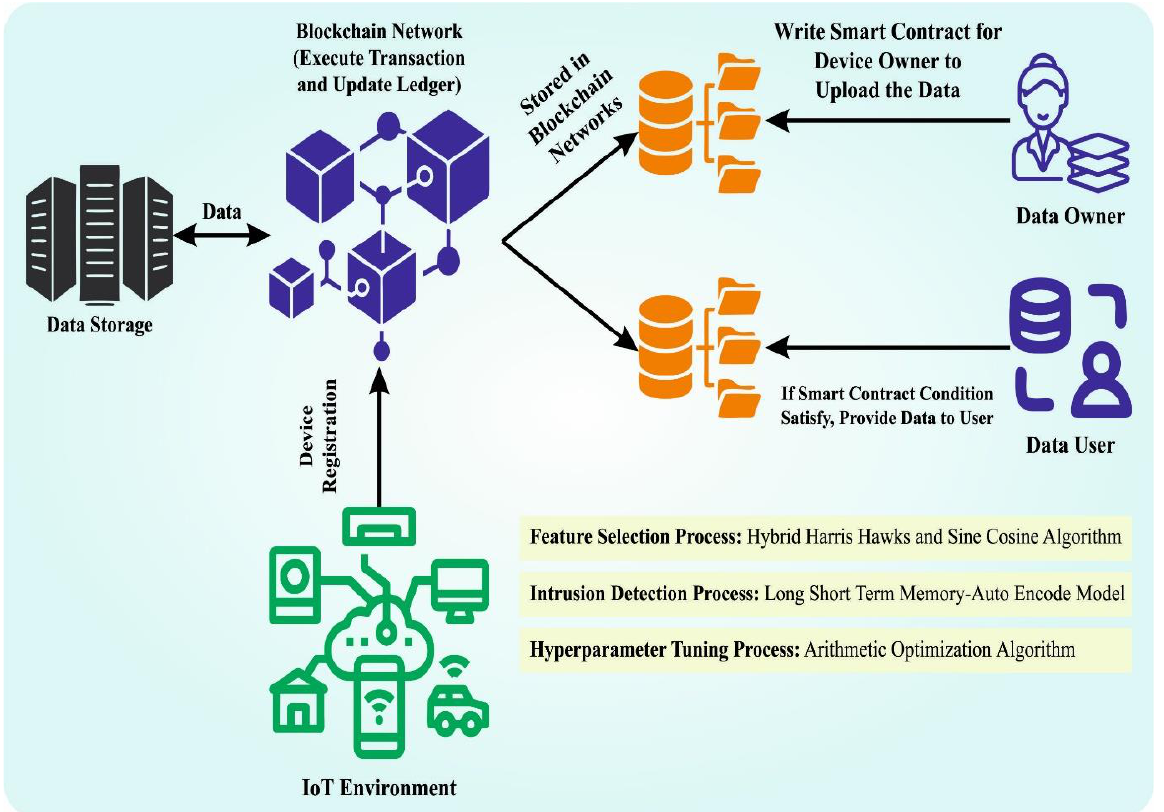
Figure 1. Overall procedure of the H3SC-DLIDS algorithm.